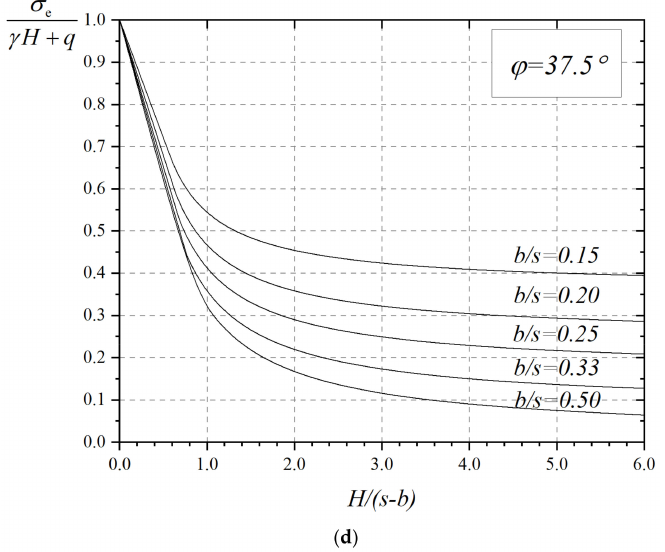
Figure 13. Vertical stresses on the subsoil; ( a ) ϕ = 30 ◦ ; ( b ) ϕ = 32.5 ◦ ; ( c ) ϕ = 35 ◦ ; ( d ) ϕ = 37.5 ◦ .